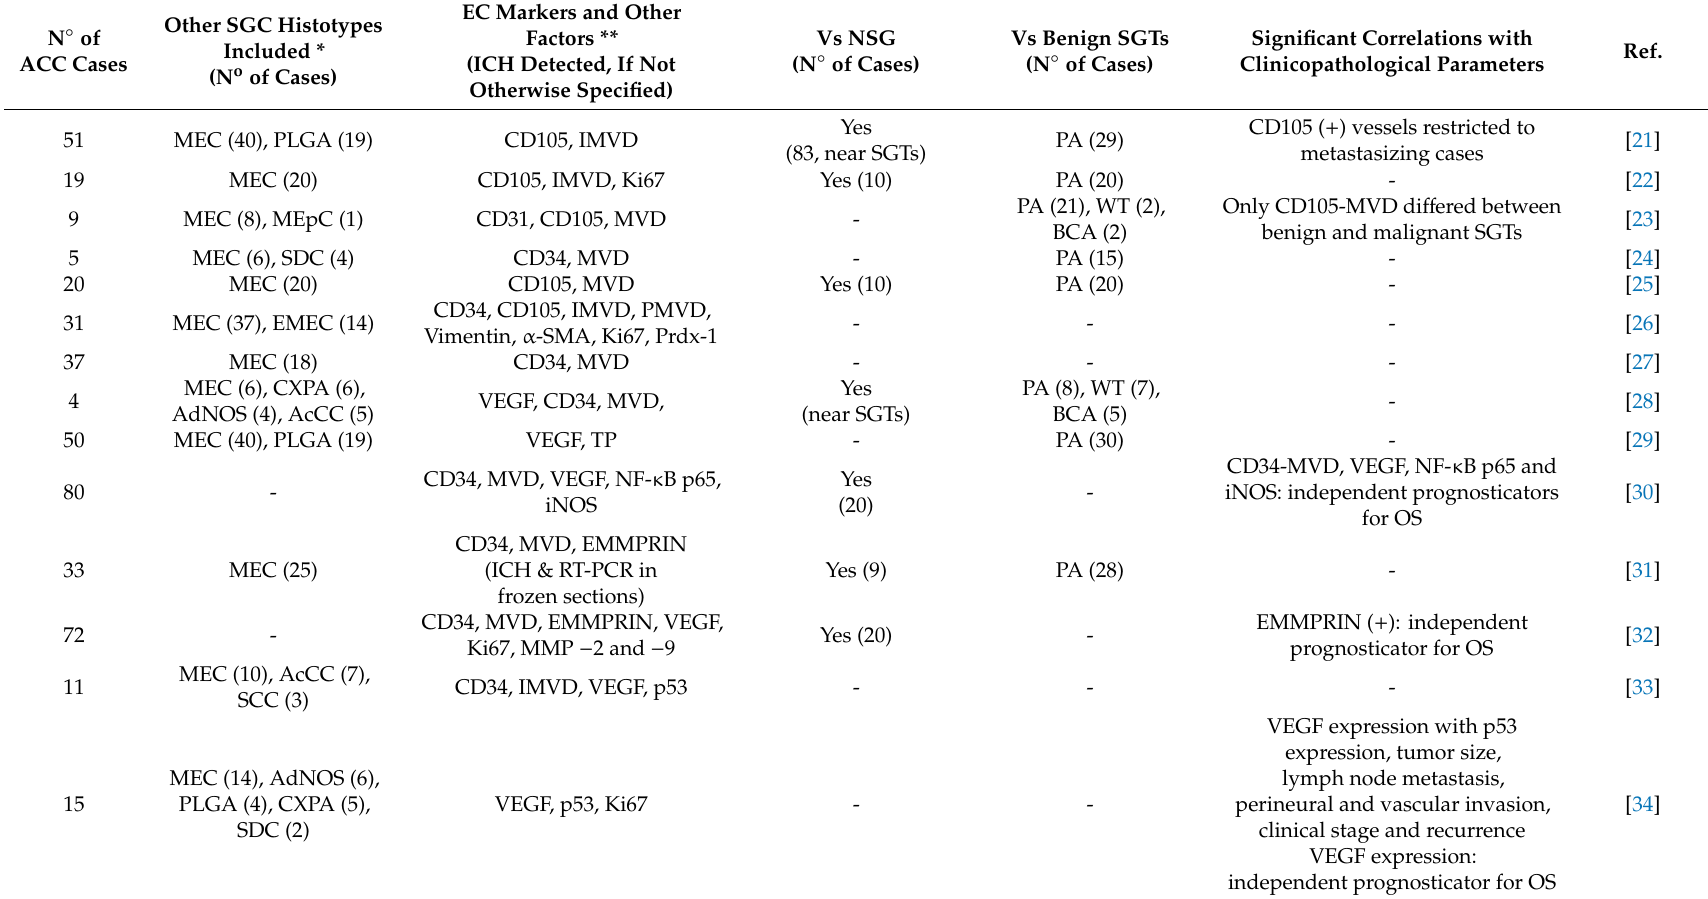
Table 1. Studies investigating the most common factors implicated in Adenoid Cystic (ACC)